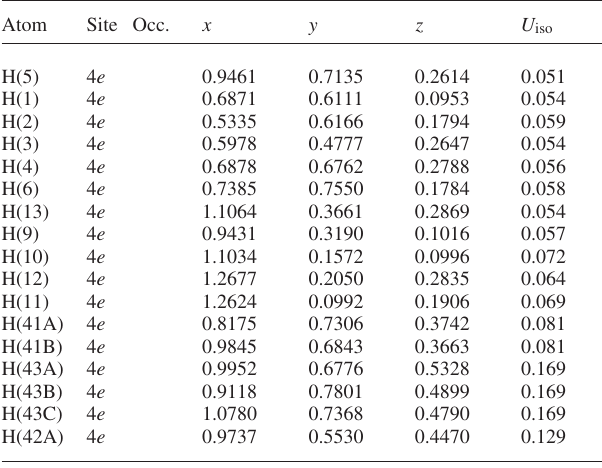
Table 2. Atomic coordinates and displacement parameters (in Å 2 )